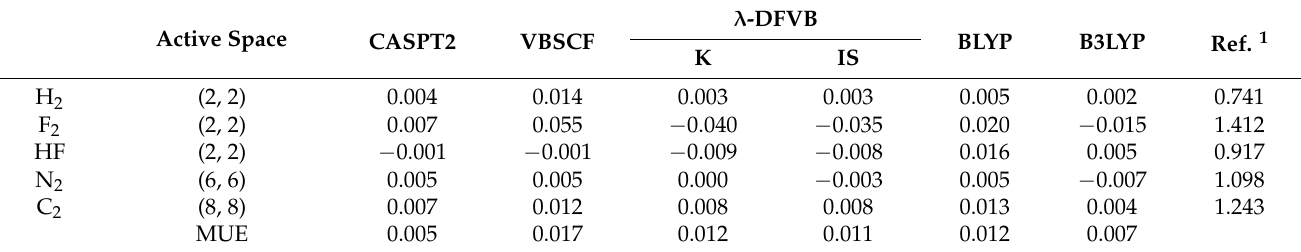
Table 1. Deviation values of the equilibrium bond lengths ( R e , in Å) of diatomic molecules. Active